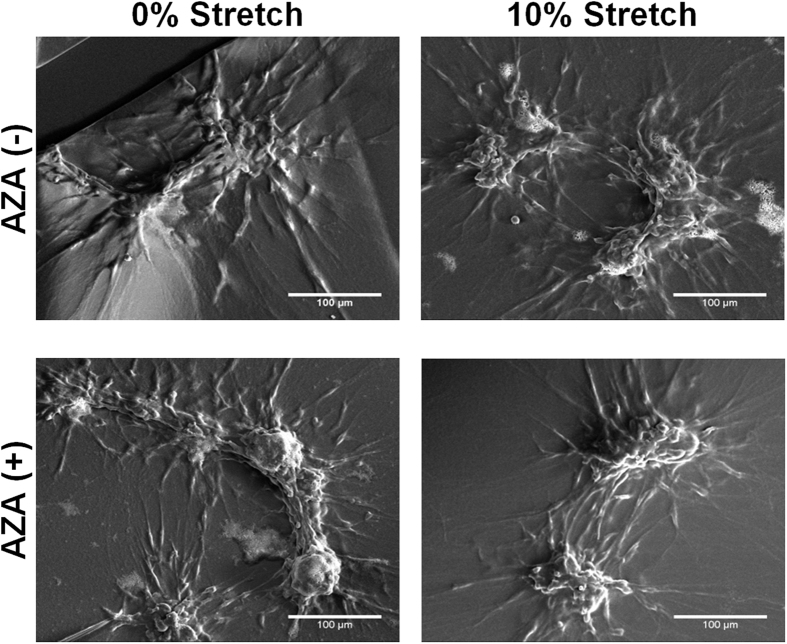
Scanning electron micrographs of astrocyte constructs.Representative scanning electron micrographs depicted no differences in astrocyte construct morphology as a function of the various injury or AZA treatments compared to control untreated samples.